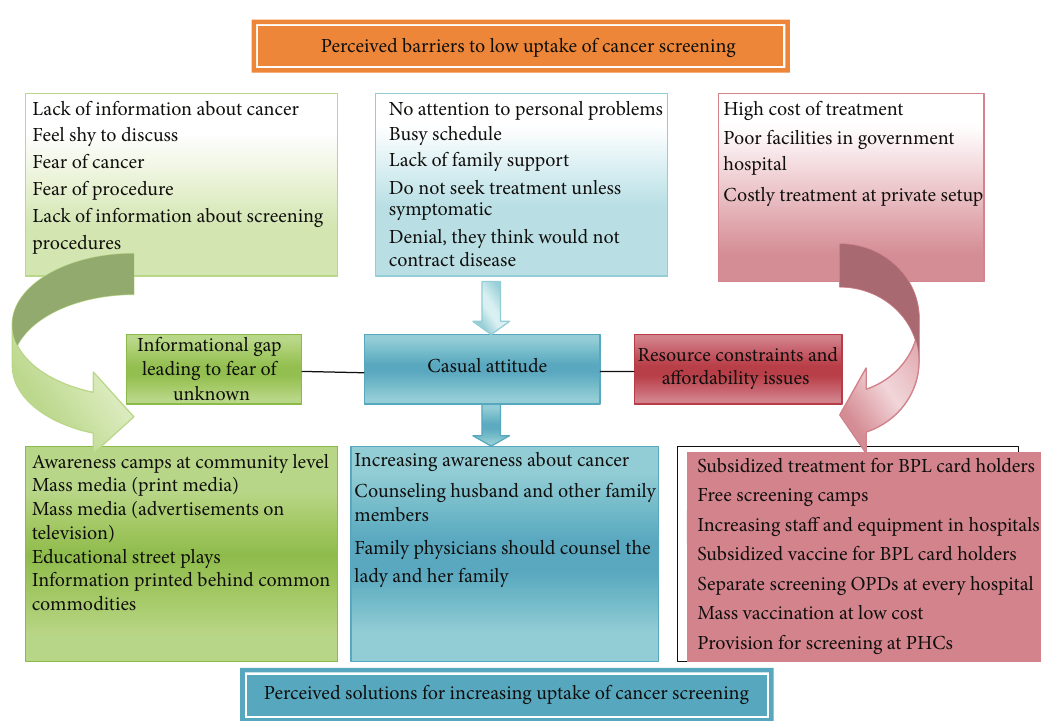
Figure 3: Overview of perceived barriers and their